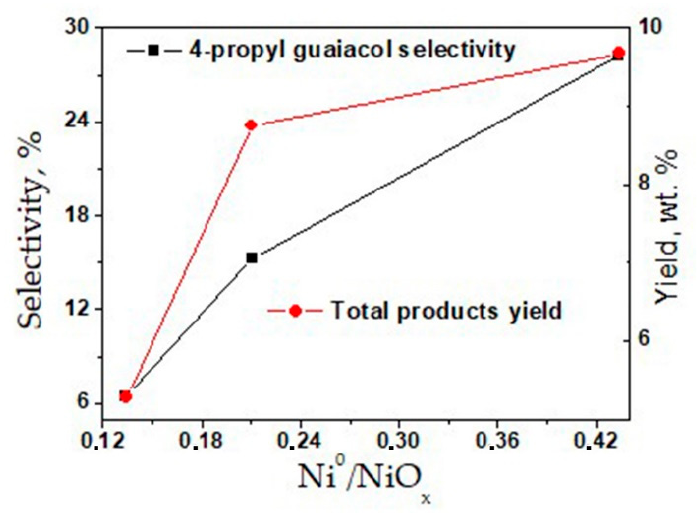
Figure 7. The influence of Ni 0 /NiO x ratio on selectivity to 4-propylguaiacol and total product yield. Lignin creates the phenyl glycosidic bonds with biomass polysaccharides forming the so-called lignocarbohydrate complex [36]. The chemical bonds between lignin and hemicel- luloses significantly affect the reactivity of biomass [37]. Acid and alkaline pretreatments may disrupt the native structure of the lignocarbohydrate complex and change its reac- tivity [33]. The acid pretreatment selectively hydrolyzes hemicelluloses in lignocellulosic biomass [38] and can significantly change the lignin structure [39]. The alkaline treatment of biomass ensures its efficient delignification under milder conditions [40]. The obtained results show that both acid and alkaline prehydrolysis of flax shives before their hydrogenation slightly (within 91–93%) changes the degree of delignification. Both types of prehydrolysis increase the yield of cellulose (from 42 to 60–73%) and solids in general (from 35 to 44–51%) (see Tables 7 and 8), and decrease the content of lignin (from 12 to 7–9%) and hemicellulose (from 2 to 1–2%). Table 7. Effect of pretreatments of flax shives on the yield of the main products in the followed fractionation process (225 ◦ C,